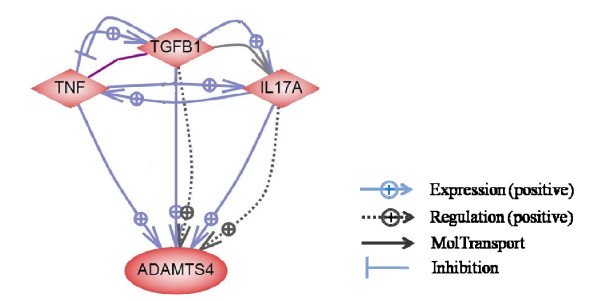
ADAMTS4 pathway. The blue solid arrow with square indicates that the regulator changes the gene expression of the target gene. The dot arrow with square indicates that the regulator changes the protein activity of the target gene. The black solid arrow indicates that the regulator changes the localization of the target gene. The blue closed line indicates that the regulator inhibits gene expression of the target gene.